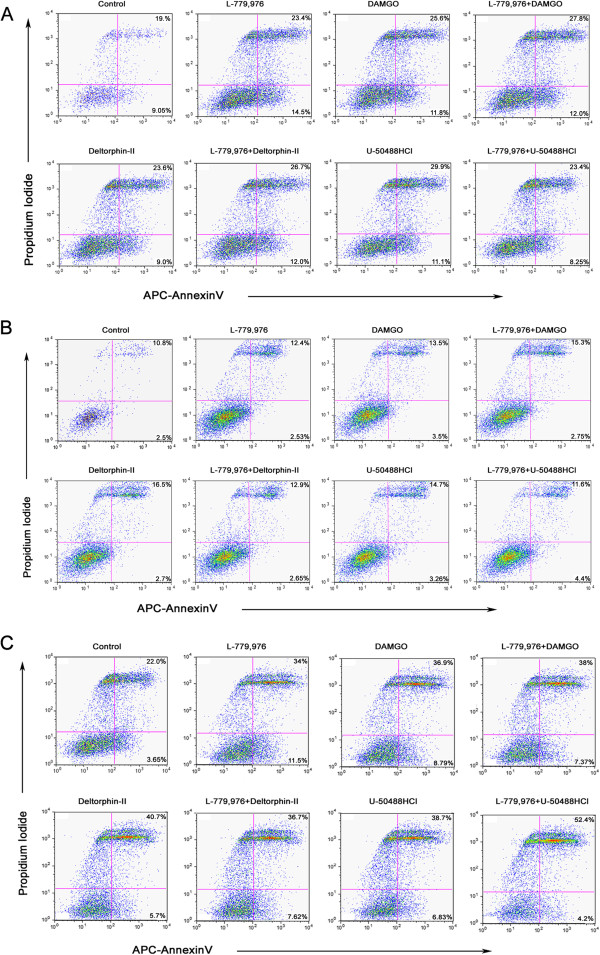
Representative flow cytometry analysis displaying apoptosis and necrosis after exposure to SSTR2 and OR agonist in breast cancer cells. Cells were harvested and treated with SSTR2 or ORs specific agonists alone and in combination for 30 min at 37°C as described in Material and Method section. The percentage of apoptosis (lower right quadrant) and necrosis (upper right quadrant) was evaluated in MCF-7 (A), MDA-MB231 (B) and T47D (C) cells upon treatment as indicated. Flow cytometry profile illustrating APC-Annexin V staining on X-axis whereas PI staining on Y-axis. A minimum of 10,000 events were recorded for each sample.